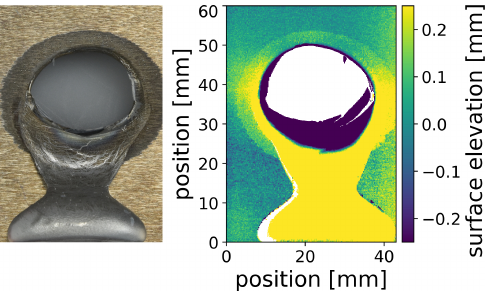
Figure 5. Images of the front side of the sample of Figure 2 after laser perforation, as photograph and as 3D surface profile. Besides the hole in the center and the flow-out material bubble at the bottom, the heat-affected area around the hole is visible.